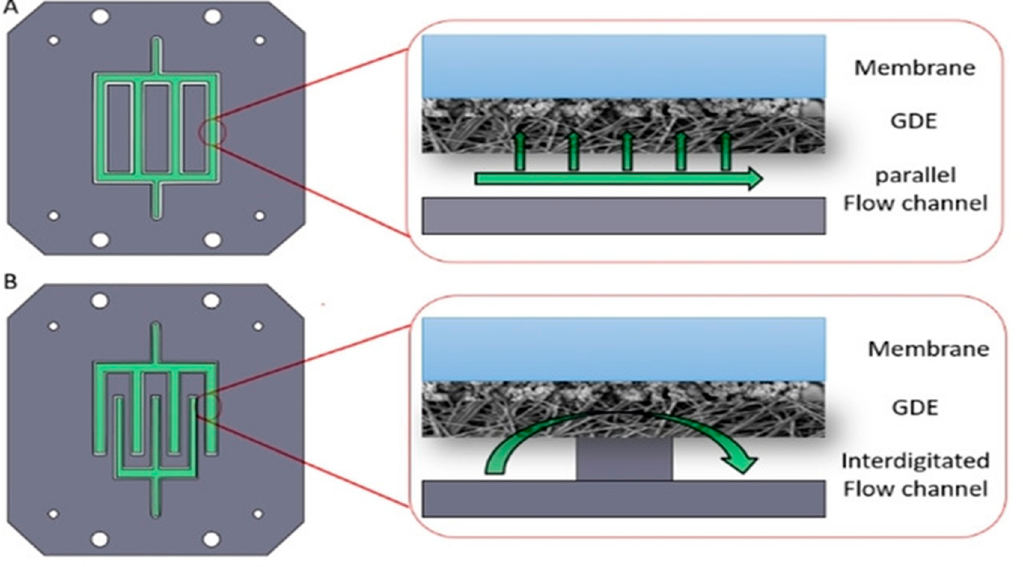
Figure 4. Schematic diagrams of the flow field patterns in the two types of zero ‐ gap electrolyzer: ( A ) the parallel pattern, in, which mass transfer is due to diffusion, and ( B ) the interdigitated pattern, in, which mass transfer is a combination of diffusion and convection. Reproduced with permission from ref. [43]. Copyright 2020, Wiley ‐ VCH.